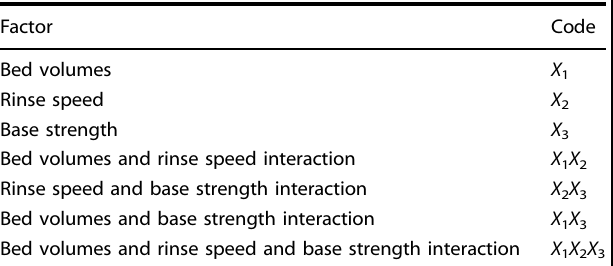
Table 4. Factors and interaction terms used in linear regression